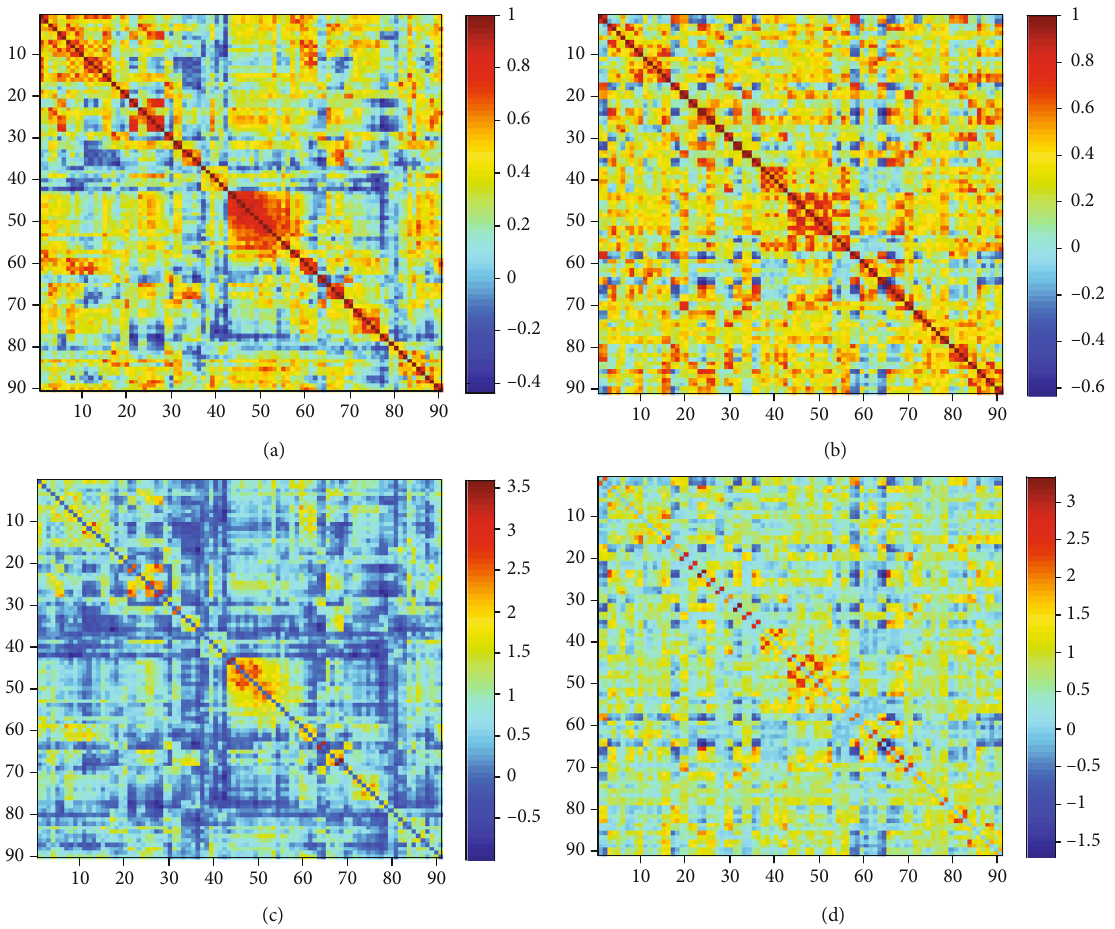
Figure 1: (a, b) Images representing the brain function connectivity matrix of a normal subject and an AD patient obtained by the Pearson method. (c, d) Images showing the brain function connectivity matrix of a normal subject and an AD patient is obtained by constrained sparse method. It can be clearly seen from the fi gure that the constraint sparse method calculates that the number of connections is